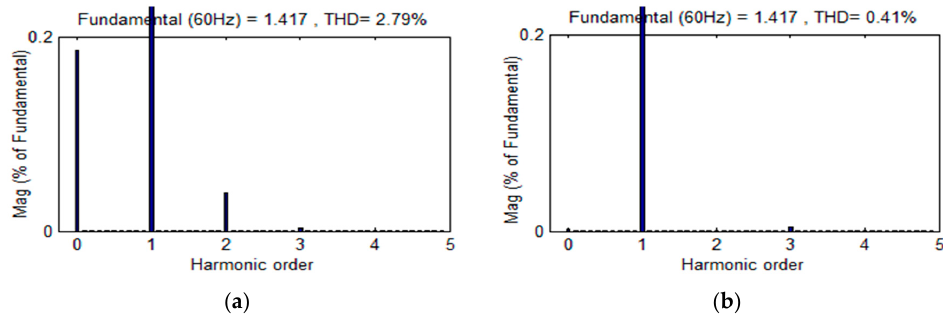
Figure 7 . Frequency spectrum of phase current: ( a ) without applying a compensation algorithm; ( b ) with applying the proposed compensation algorithm.